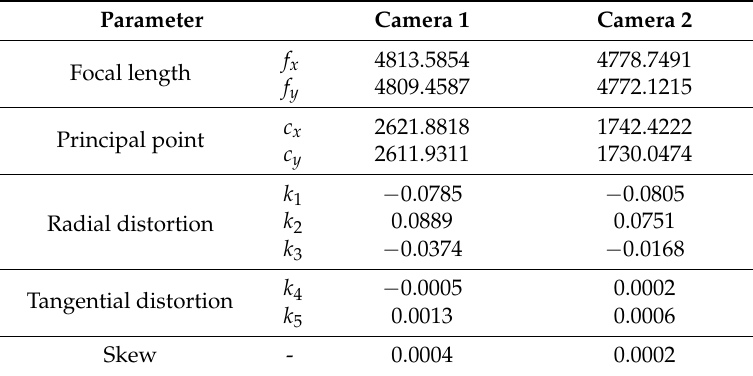
Table 4. Intrinsic parameters (internal orientation) of the cameras. The abbreviations stand for focal point ( f ), coordinate ( c ), and parameter in the polynomial function correcting for distortions ( k ). x and y refer to the axis directions.